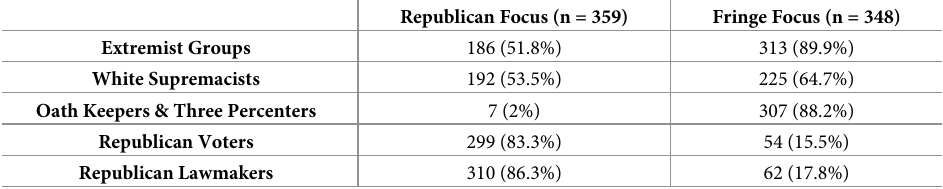
Table 7. Cell counts and percentages for groups recalled in Capitol riot description by focus condition.